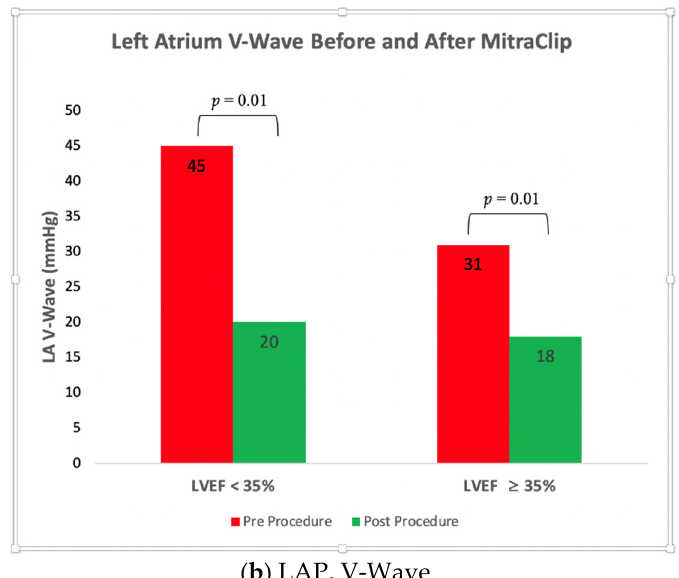
Figure 2. Left Ventricle Ejection Fraction (LVEF) and Left Atrial Pressure (LAP) before and after the procedure. ( a ) There was no significant change in Left ventricle ejection fraction (LVEF) before and after MitraClip procedure in both LVEF < 35% and LVEF ≥ 35% groups; ( b ) There was a significant reduction in LAP before and after MitraClip procedure in both LVEF < 35% and LVEF ≥ 35% groups.